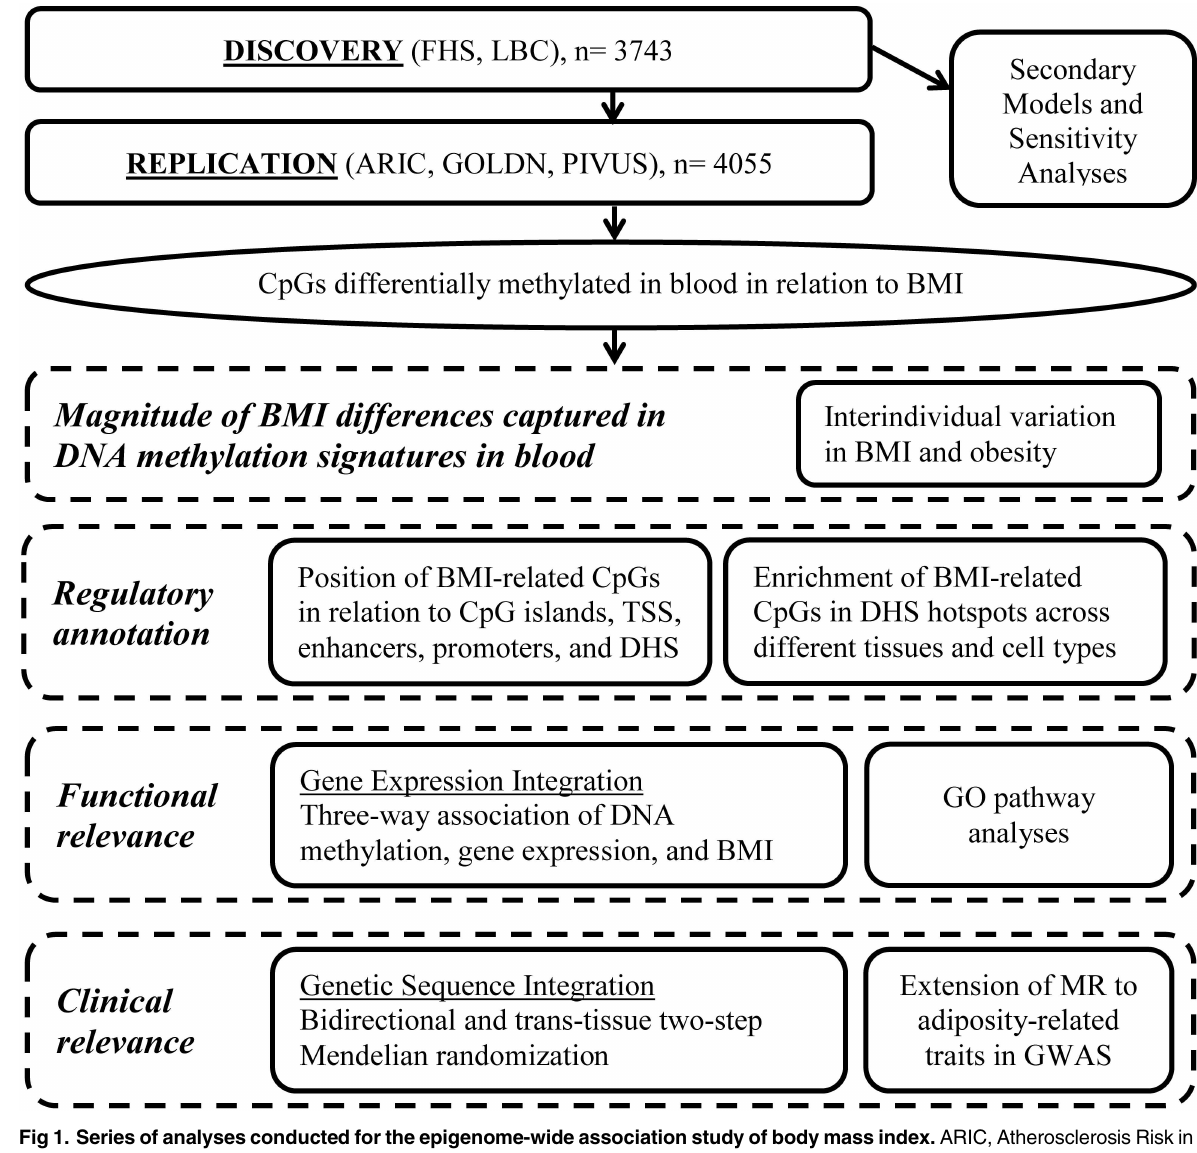
Fig 1. Series of analysesconducted for the epigenome-wide association study of body mass index. ARIC, Atherosclerosis Risk in Communities; BMI, body mass index; DHS, DNase I hypersensitive site; FHS, Framingham Heart Study; GO, Gene Ontology; GOLDN, Genetics of Lipid Lowering Drugs and Diet Network; GWAS, genome-wide association study; LBC, LothianBirth Cohorts; MR, Mendelian randomization; PIVUS, Prospective Investigationof the Vasculature in Uppsala Seniors; TSS, transcription start